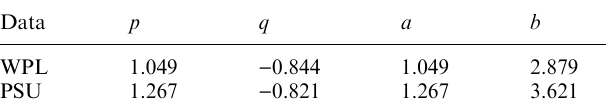
Table A4. Parameters of fitted Weibull distributions for the thickness H (km) of cirrus estimated from p and